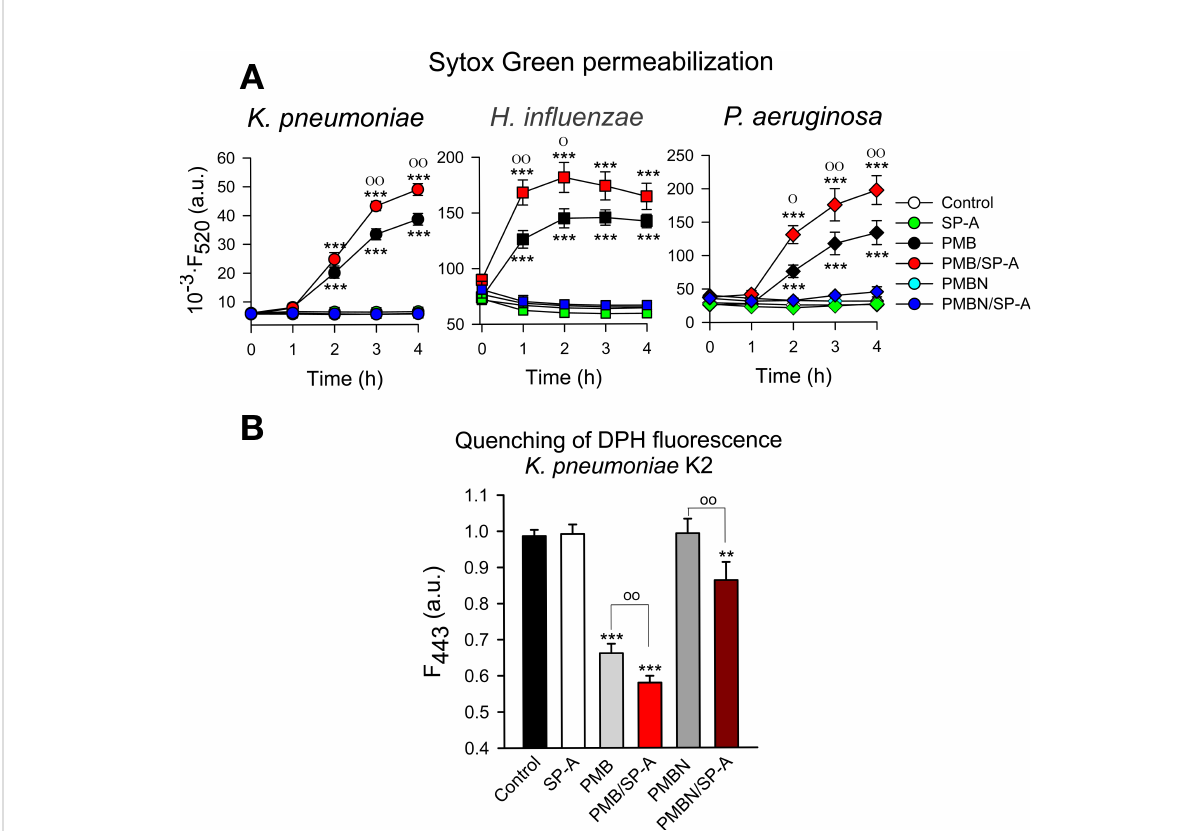
FIGURE 9 Membrane integrity of Gram-negative bacteria. (A) 10 7 CFU/ml of ( K ) pneumoniae , NTHi, and PAO1 were incubated with polymyxins (PMB or PMBN) and/or SP-A (100 m g/ml) in the presence of Sytox Green, and the change in the fl uorescence of the dye was recorded as a function of time. The experiments were conducted at 37°C. PMB concentrations: 1 m g/ml for K pneumoniae ; 0.5 m g/ml for NTHi and PAO1. PMBN concentrations: 1 m g/ml for K pneumoniae ; 2 m g/ml for NTHi; 0.5 m g/ml for PAO1. (B) 10 7 CFU/ml of K pneumoniae were incubated with or without PMB (1 m g/ml), PMBN (1 m g/ml) and/or SP-A (100 m g/ml) in the presence of 1,6-diphenyl-1,3,5-hexatriene (DPH), and the change in the fl uorescence of DPH was recorded as a function of time. Data shown correspond to the fl uorescence of DPH after treatment with SP-A and/or polymyxins for 30 min. Experiments were performed at 37°C. The results are the mean ± SD of three independent experiments, each in triplicate. Results were statistically analyzed by one-way ANOVA followed by the Bonferroni multiple-comparison test: ** p < 0.01; *** p < 0.001 compared to untreated bacteria (control); о p < 0.05; оо p < 0.01 when bacteria treated with SP-A+polymyxin (PMB or PMBN) were compared with bacteria treated with PMB or PMBN